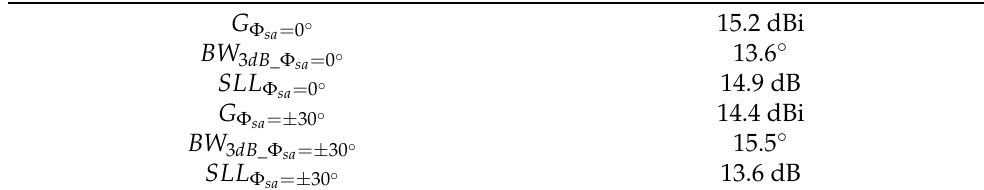
Table 1. Main parameters of the surveillance array (Figure 3) [5]. G Φ gain at steering angles (sa) 0 ◦ and ± 30 ◦ , respectively, BW 3 dB _ Φ (HPBW) for both steerings, and SLL Φ